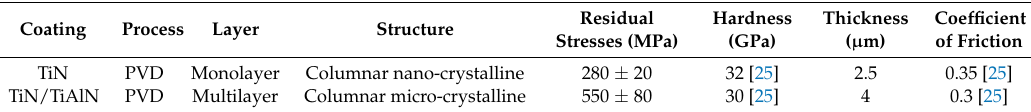
Table 3. Characteristics of coating